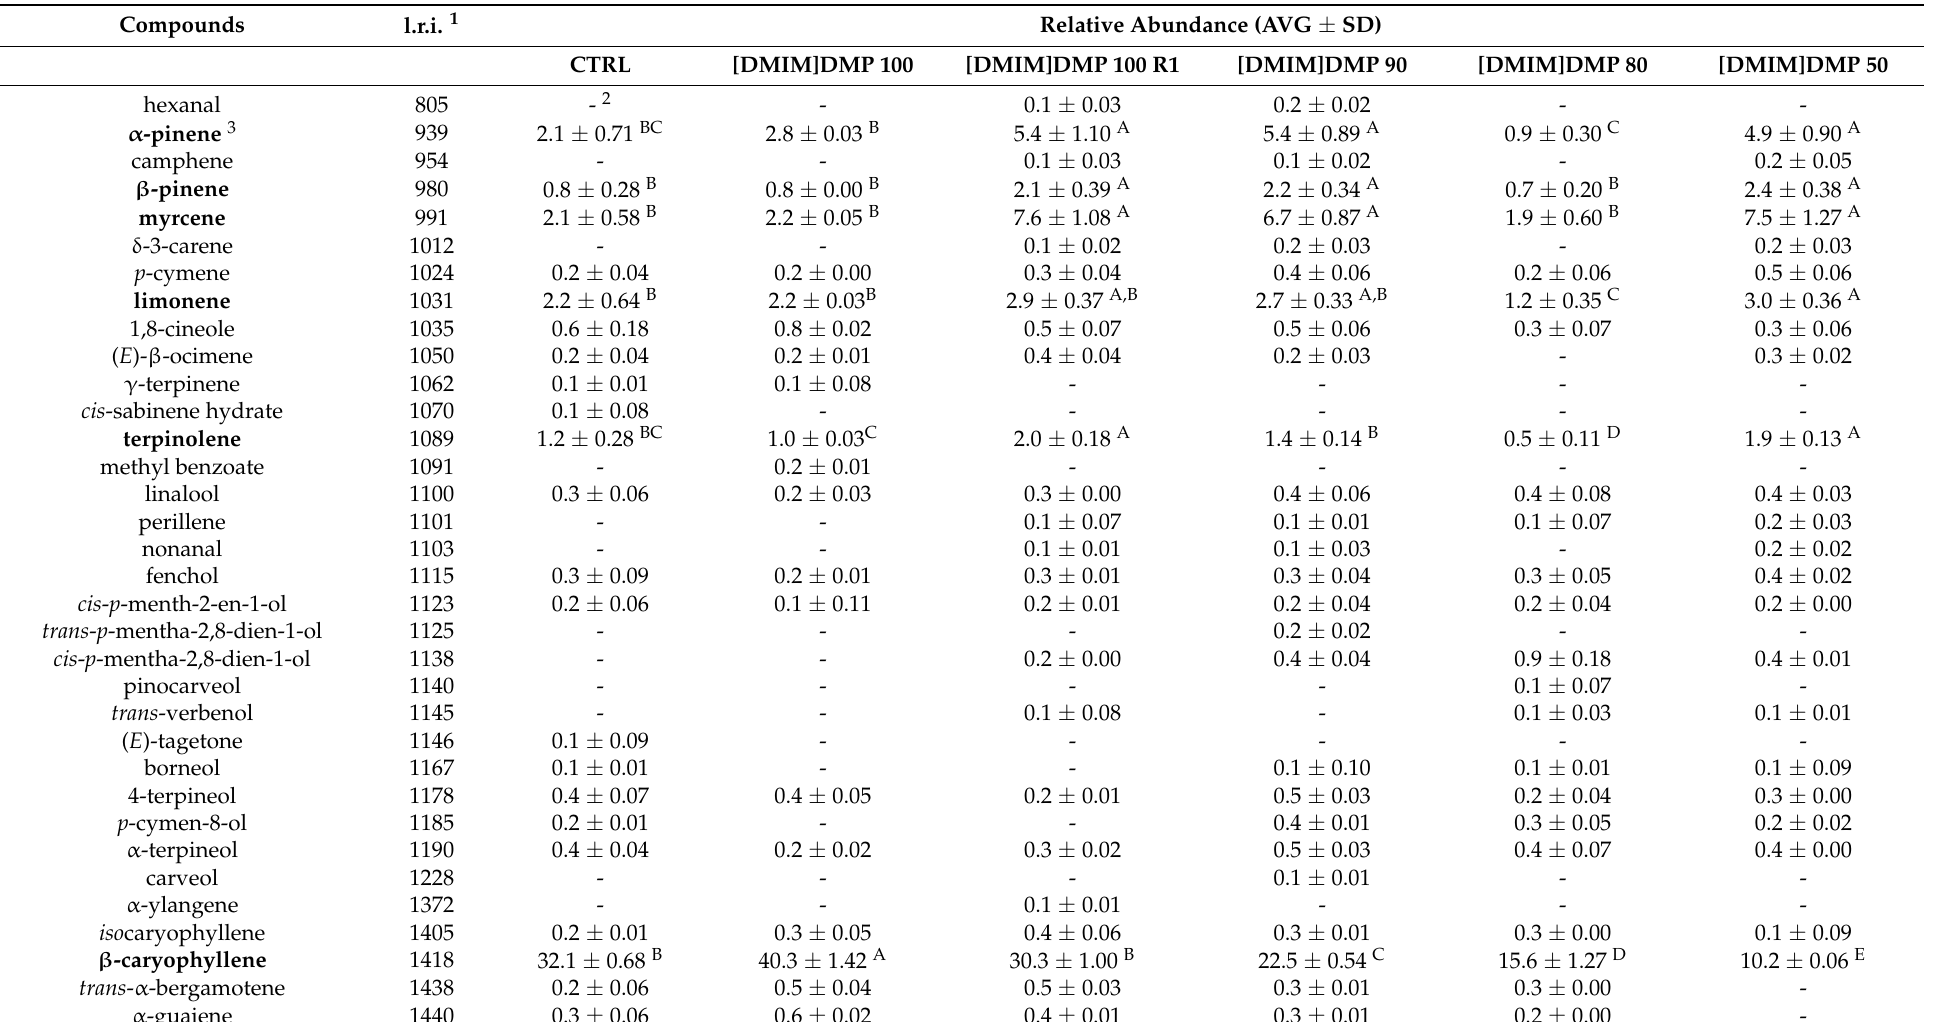
Table 1. Complete compositions of the hemp essential oil extracted from all the